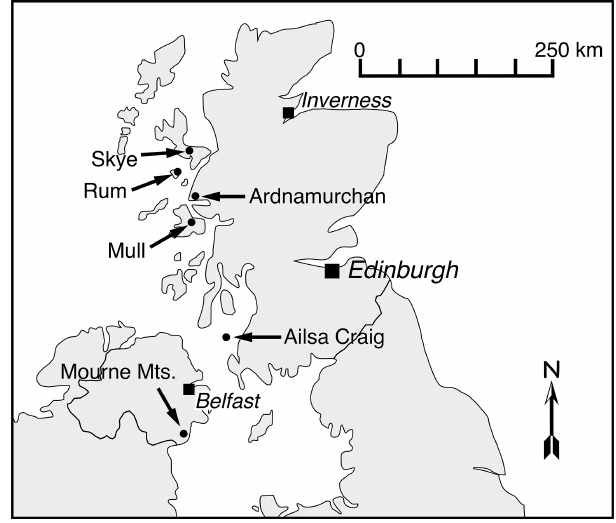
Figure 1. Location of Paleogene granitic bodies studied here. De- tailed geological maps of the bodies may be found in Emeleus and Bell (2005). The samples used here are a subset of those used in studies of minerals of the chevkinite group (Macdonald et al., 2013a) and apatite supergroup (Macdonald et al., 2013b) (Table